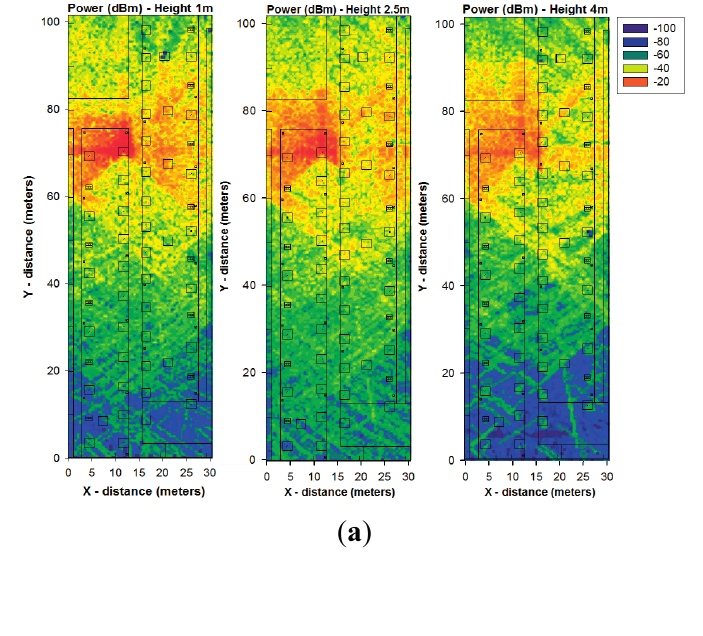
Figure 5. Estimation of received power (dBm) on the vegetation environment obtained by the 3D Ray Launching algorithm ( a ) For the transmitter antenna placed at a fixed point and for different heights ( b ) For two different points of the transmitter antenna for the same